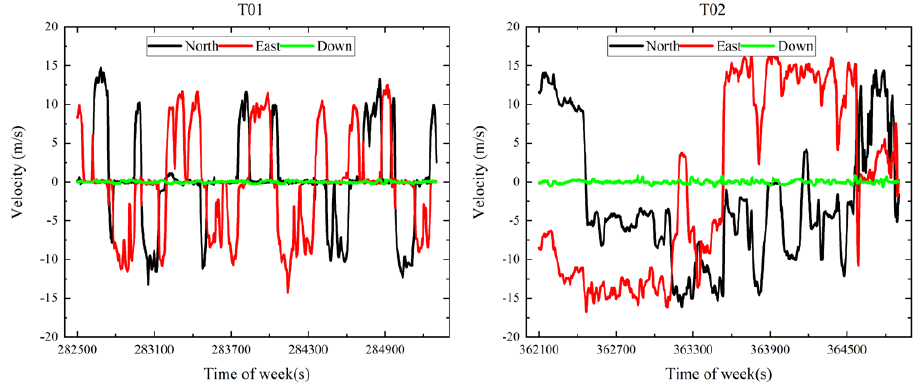
Figure 3. The test trajectory and typical scenarios of T01 (left panel) and T02 (right panel).